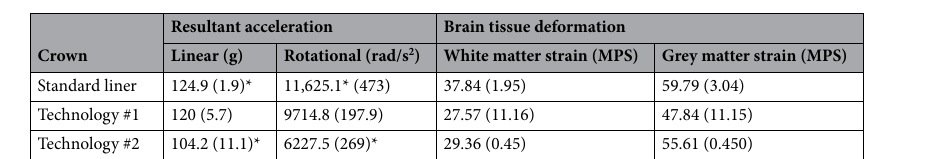
Table 3. Summary table with means of impact variables measured along with the standard deviations in brackets for the crown location. *Indicates significant difference (alpha level p < 0.05), when the two technologies are compared to the standard liner.